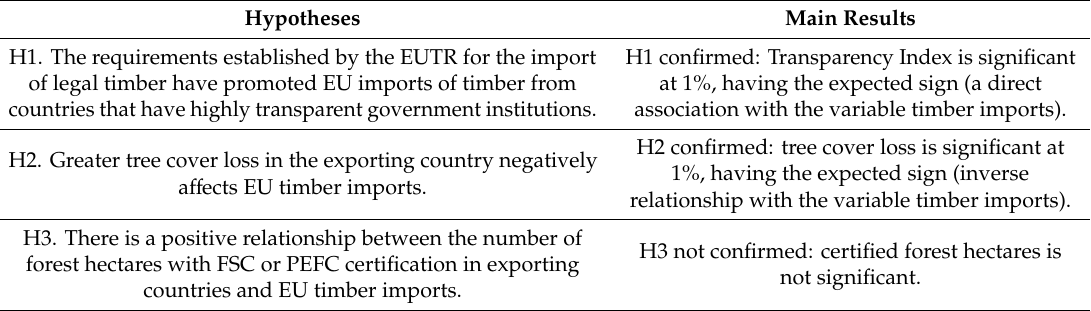
Table 6. Hypotheses and main results. EUTR: EU Timber Regulation, FSC: Forest Stewardship Council and PEFC: Program for the Endorsement of Forest